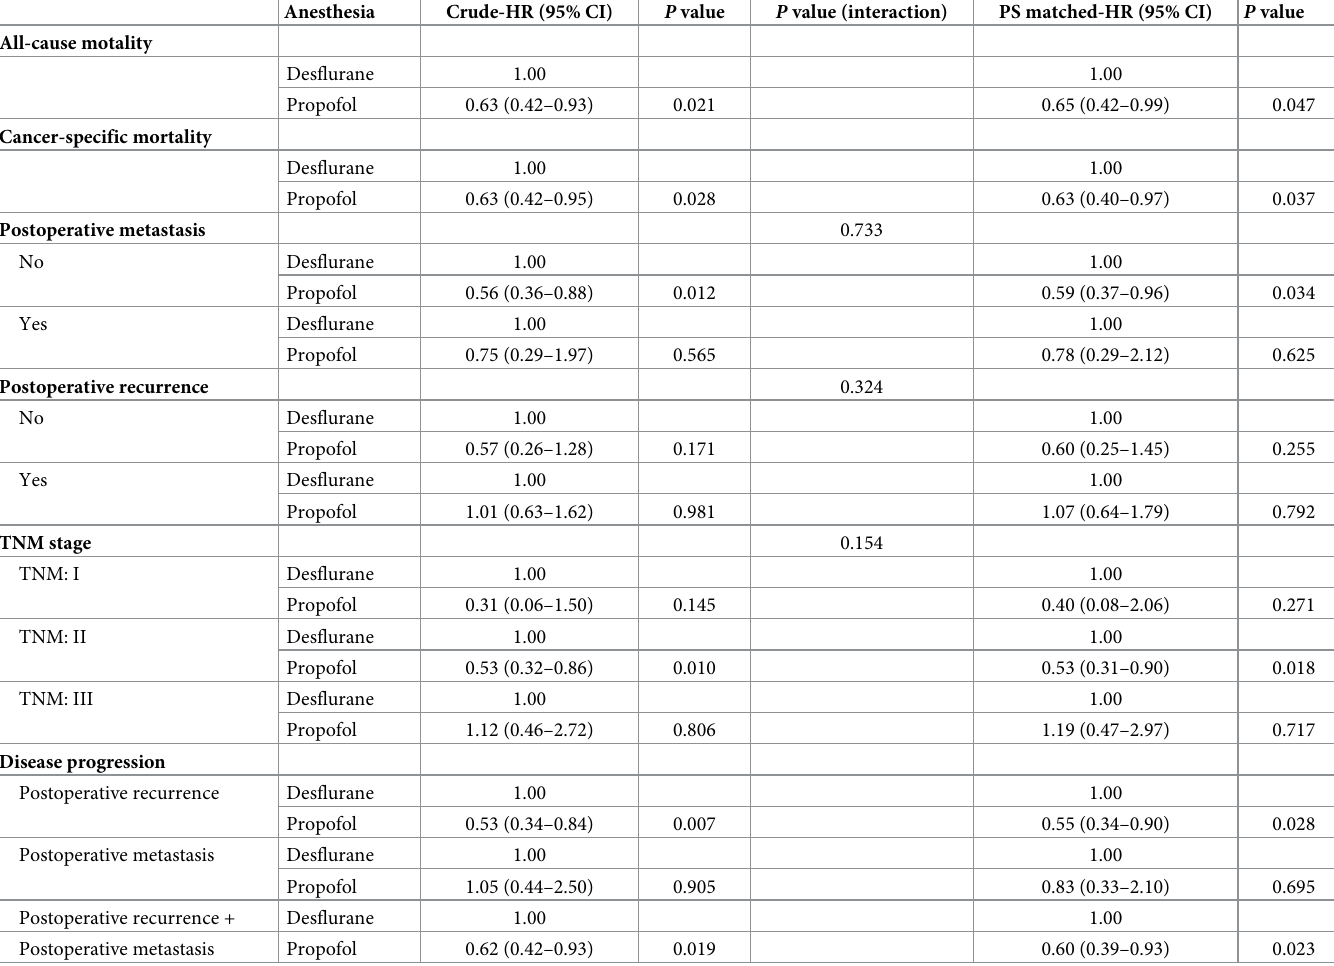
Table 3. Subgroup analyses for all-cause mortality, cancer-specific mortality, presence of postoperative metastasis, postoperative recurrence, TNM stage, and dis- ease